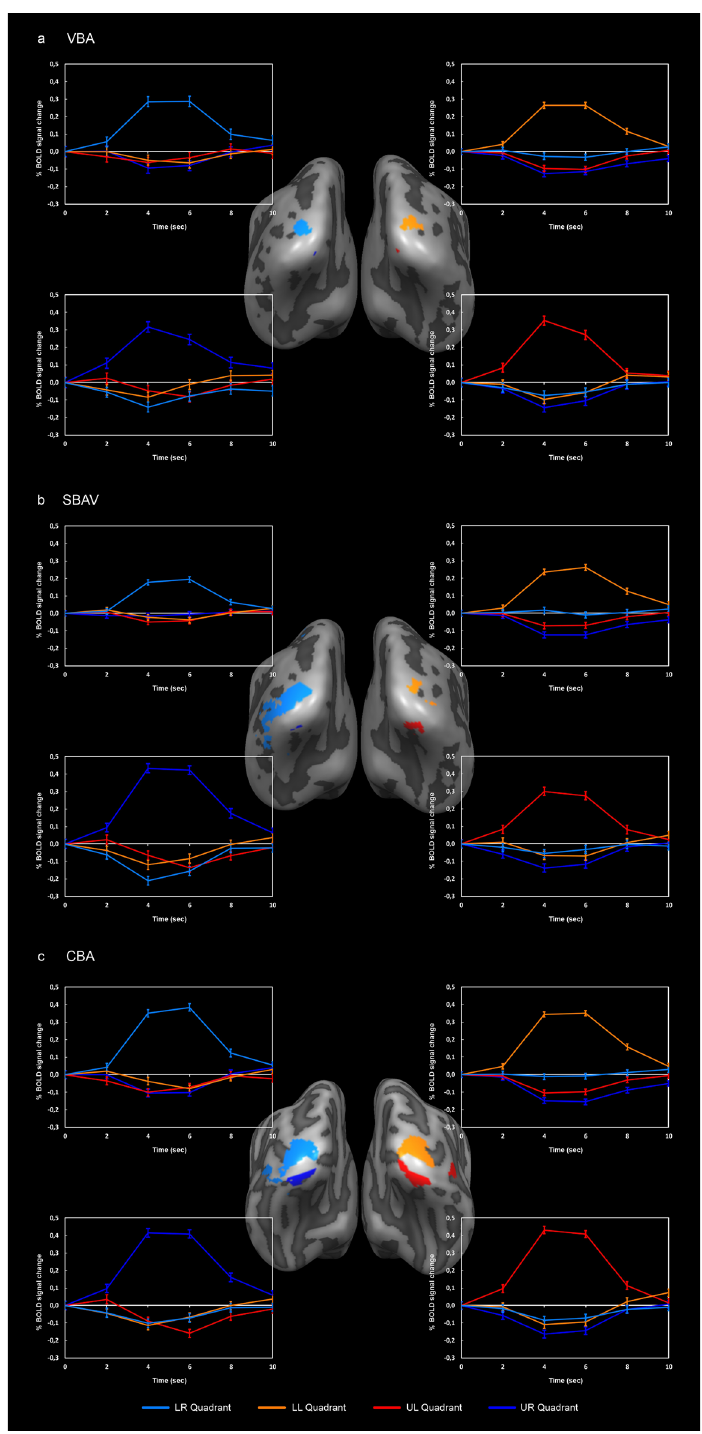
Figure 1. Group analysis of visual quadrants. ( a ) VBA results. Maps and average timecourses were computed in volume space; maps were projected on the non-aligned average surface representation. ( b ) SBAV results. Maps and average timecourses were computed in surface space; maps were projected on the non-aligned surface representation. ( c ) CBA results. Maps and average timecourses were computed in surface space; maps were projected on the aligned average surface representation. Overall, two out of four visual quadrant ROIs exhibited a pattern of continuously increasing cluster size, reflecting an increasing extent of significant position selectivity across alignment techniques. Additionally, while ROI size for the lower left visual quadrant decreased slightly from VBA to SBAV, ROI size for CBA was also by far the largest. Only the ROI of the lower right visual quadrant showed a cluster size decrease after CBA. Average timecourses (incl. standard error of the mean) showed clear position selectivity with a strong BOLD signal increase for the position of interest and no BOLD signal increase for the other three positions. ROI/graph colors: light-blue = lower right (LR) visual quadrant, orange = lower left (LL) visual quadrant, red = upper left (UL) visual quadrant, dark-blue = upper right (UR) visual